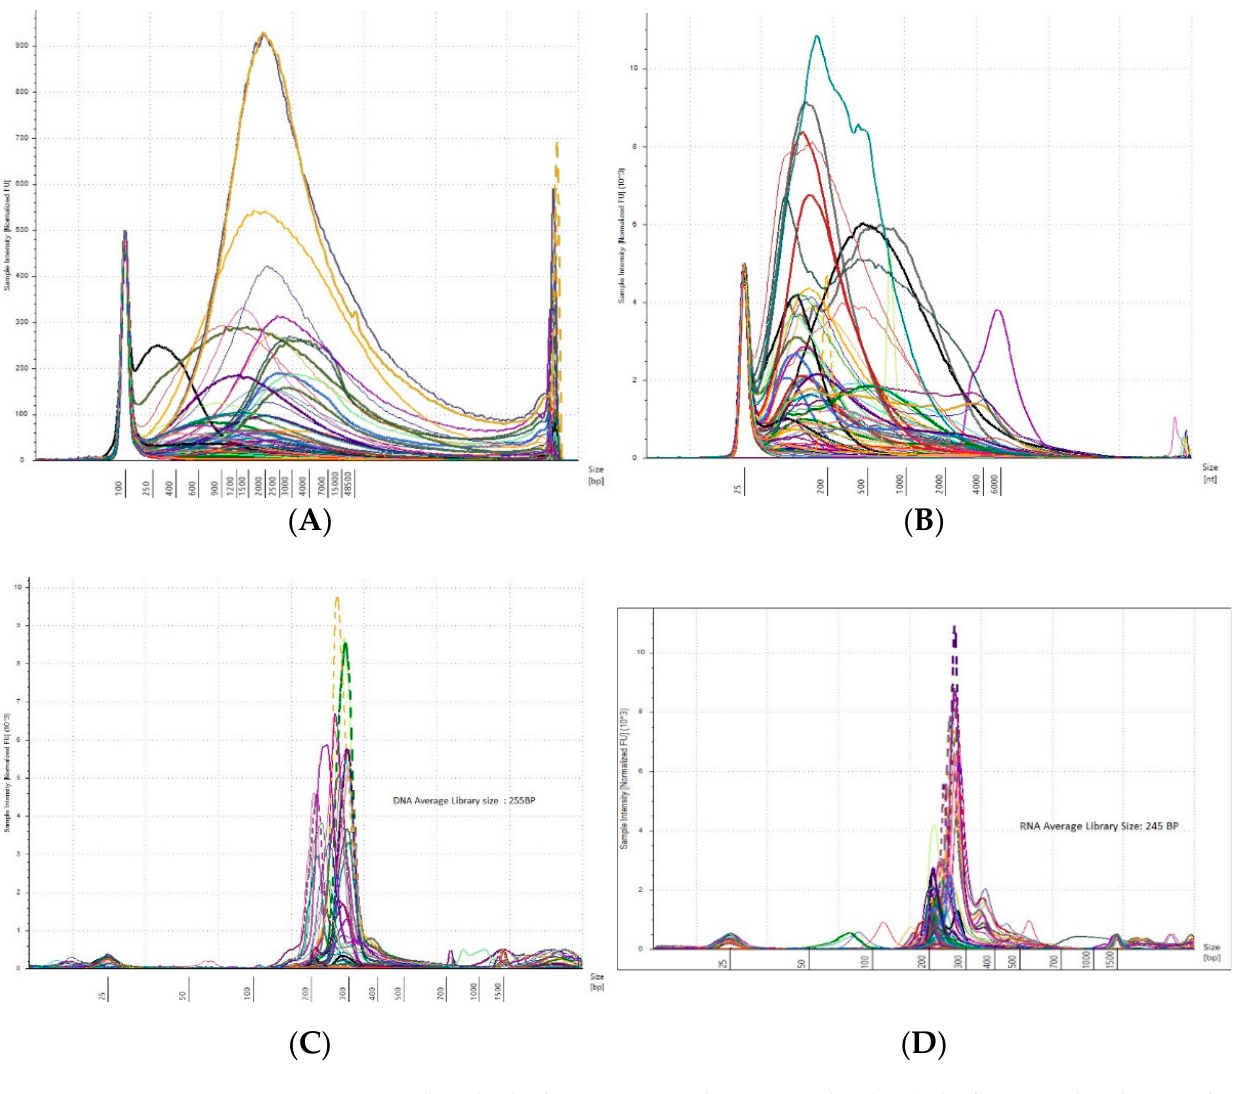
Figure 1. Quality check of FFPE DNA and RNA samples. ( A , B ): the fragment distribution of FFPE DNA and RNA samples on TapeStation, respectively. This shows the variation in nucleic acid extracted from FFPE samples before the library preparation ( Left to Right ). ( C , D ): the FFPE DNA library and RNA library, respectively. The average library size observed in the study for DNA is 255 bp and RNA is 245 bp ( Left to Right ).